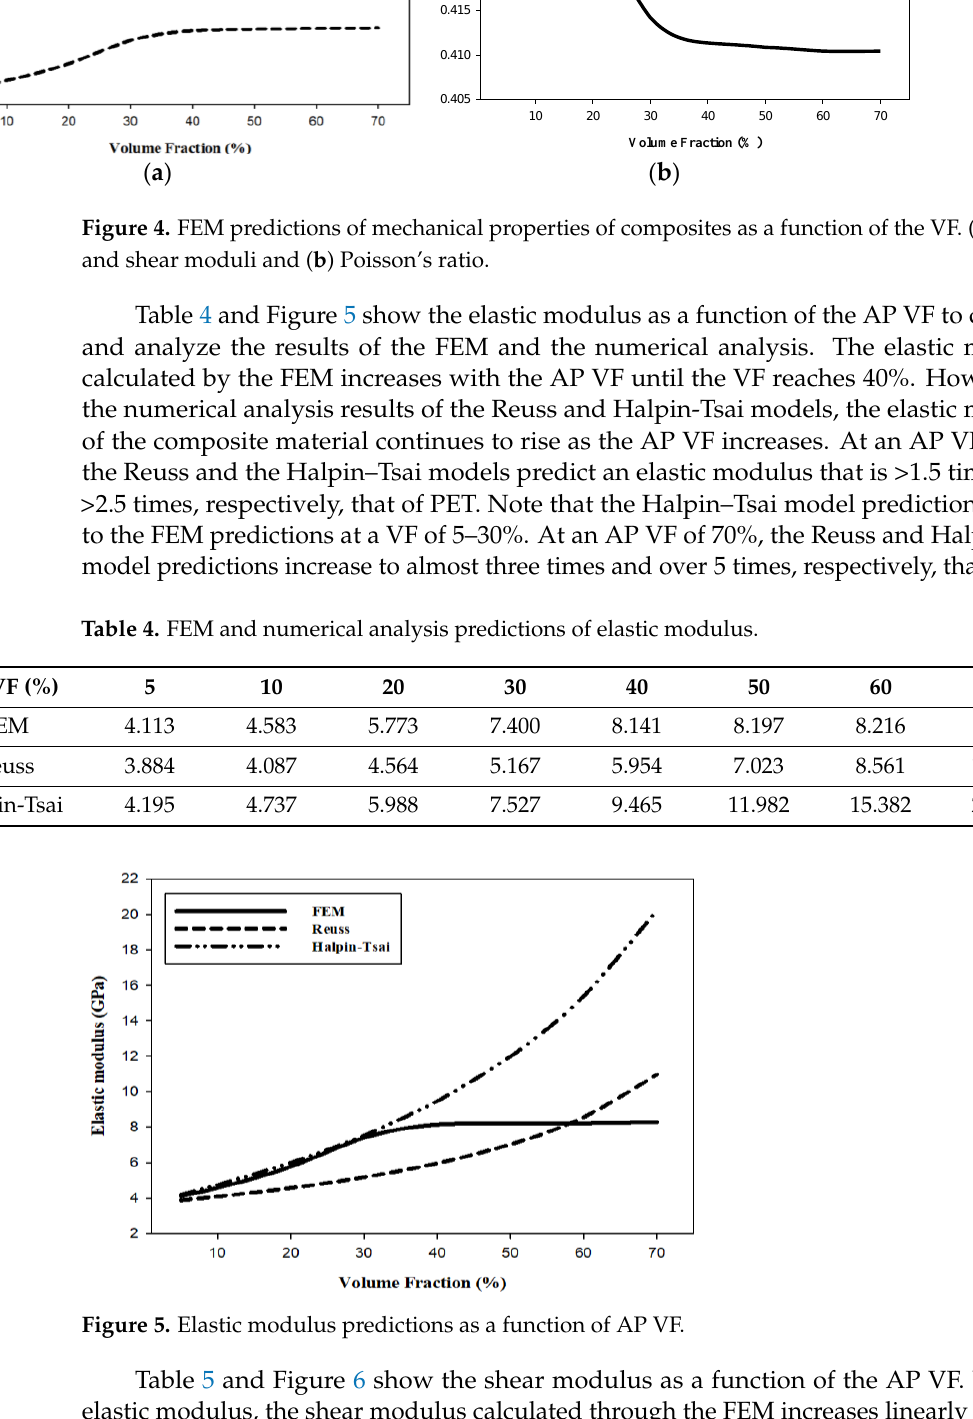
Figure 4. FEM predictions of mechanical properties of composites as a function of the VF. ( a ) Elastic and shear moduli and ( b ) Poisson’s ratio. Table 3. FEM predictions of elastic modulus, shear modulus, and Poisson’s ratio.